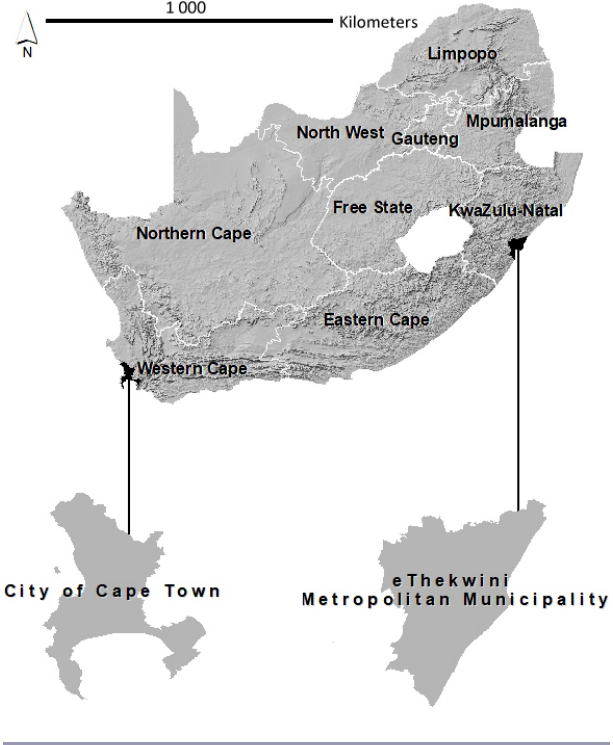
Fig. 1. Location of the study areas, Cape Town and Durban, in South